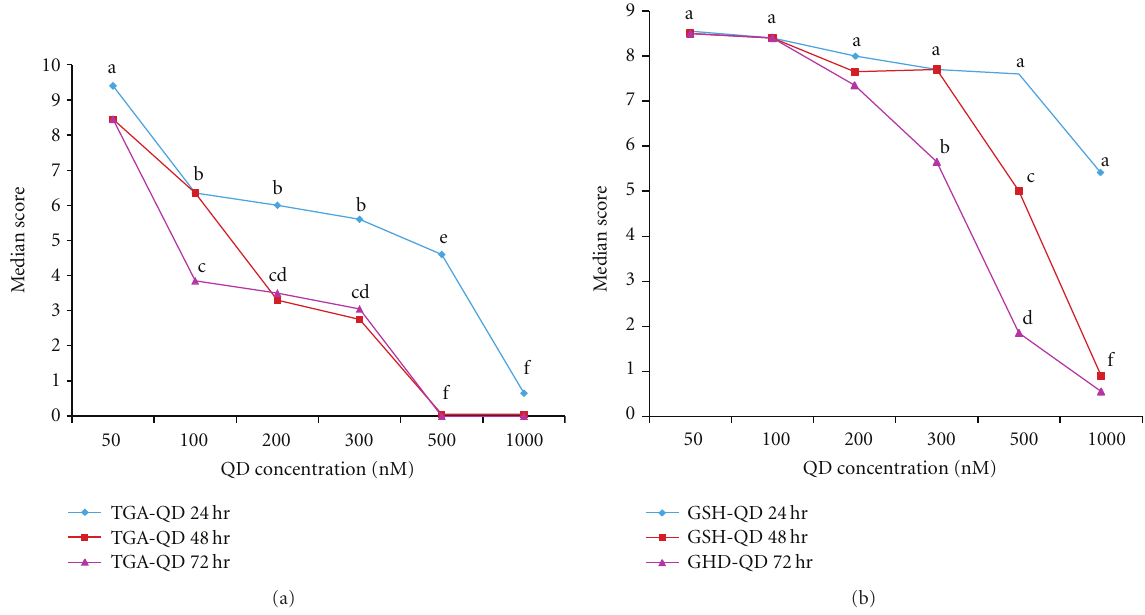
Figure 3: Dose response toxicity curves to (a) TGA- and (b) GSH-capped QDs. 20 Hydra were treated with the indicated QD at increasing concentrations for 2 hours and then, following extensive washing, allowed to recover in physiological solution for 24 hr (blue line), 48 hr (red line), and, 72hr (purple line), when morphology was appropriately scored. Median scores of morphological condition were compared by nonparametric Friedman Test; values with a letter in common are not significantly di ff erent ( P < . 001). The toxicity of TGA-and-GSH capped QDs on Hydra morphology increases with time and